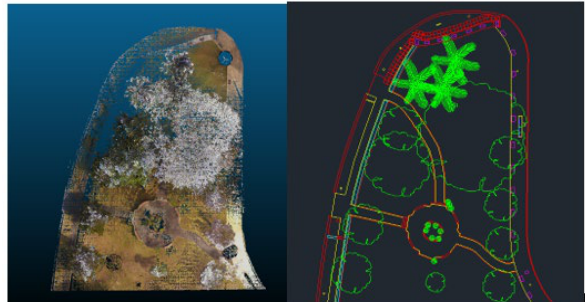
Figure 3.1 Actual representative of site, 3D point cloud from CloudCompare (left) and digitized 2D based map (right)